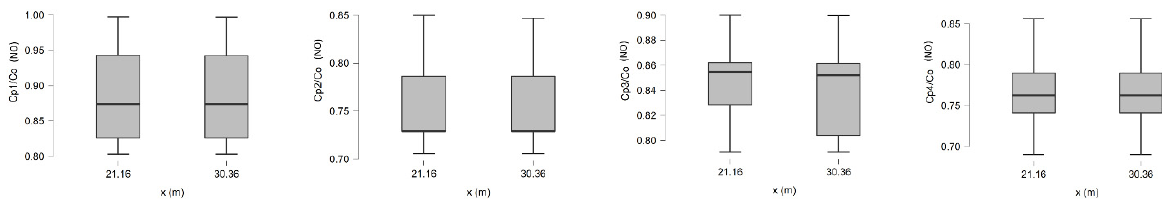
Figure 6. Cp/Co for SF 6 using the Idaho Falls Tracer Experiment (Data 3) for unstable atmospheric conditions concerning the downwind distances.